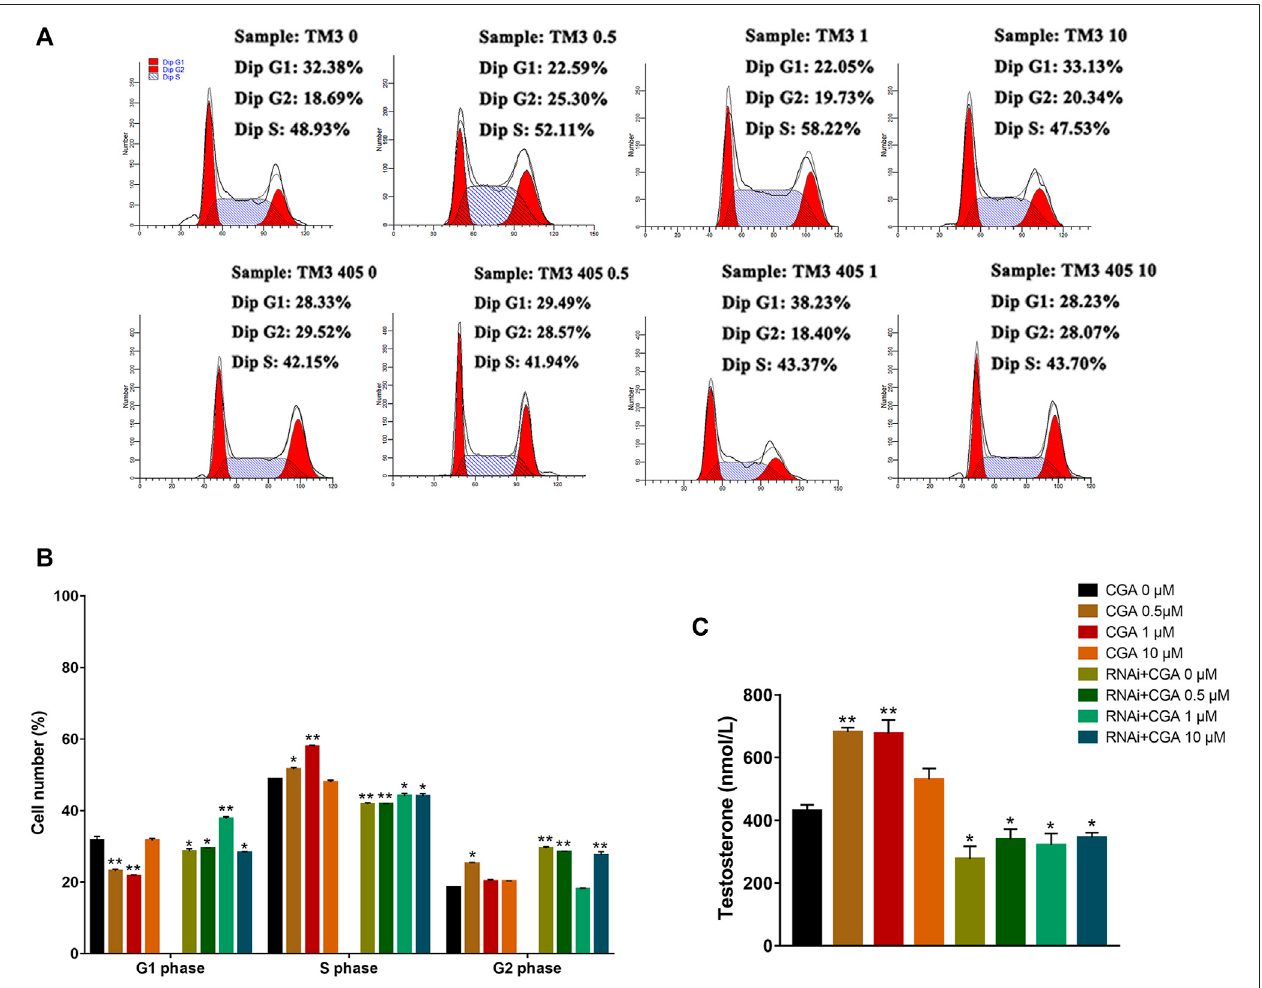
FIGURE7| EffectofCGAontestosteronesecretioninleydigcells.TM3cellsand Shp2 knockdownTM3cells(RNAi)wereculturedwithCGA(0.5,1,and10 μ M)for 36 h; the cell cycle was measured by FACS, and testosterone secretion was measured by ELISA. (A) FACS analysis of the cell cycle. (B) The results of statistical analyses. (C) ELISA analysis of the effect of CGA on testosterone secretion. Values are expressed as the mean ± SD ( n = 3). * p < 0.05, ** p < 0.01 vs CGA 0 μ M.